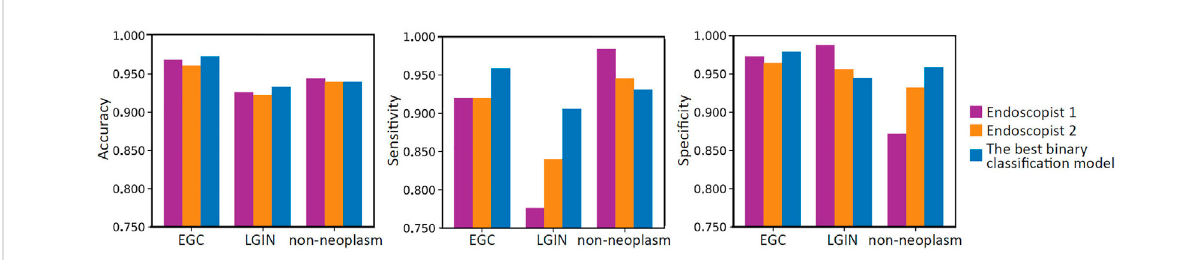
FIGURE 3 Bar charts compare the per-category accuracy, sensitivity, and speci fi city between two endoscopists and the best model.